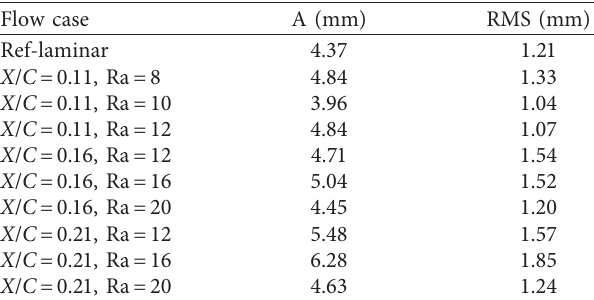
Table 4: RMS of average shock oscillations and shock amplitude for flow cases with roughness.